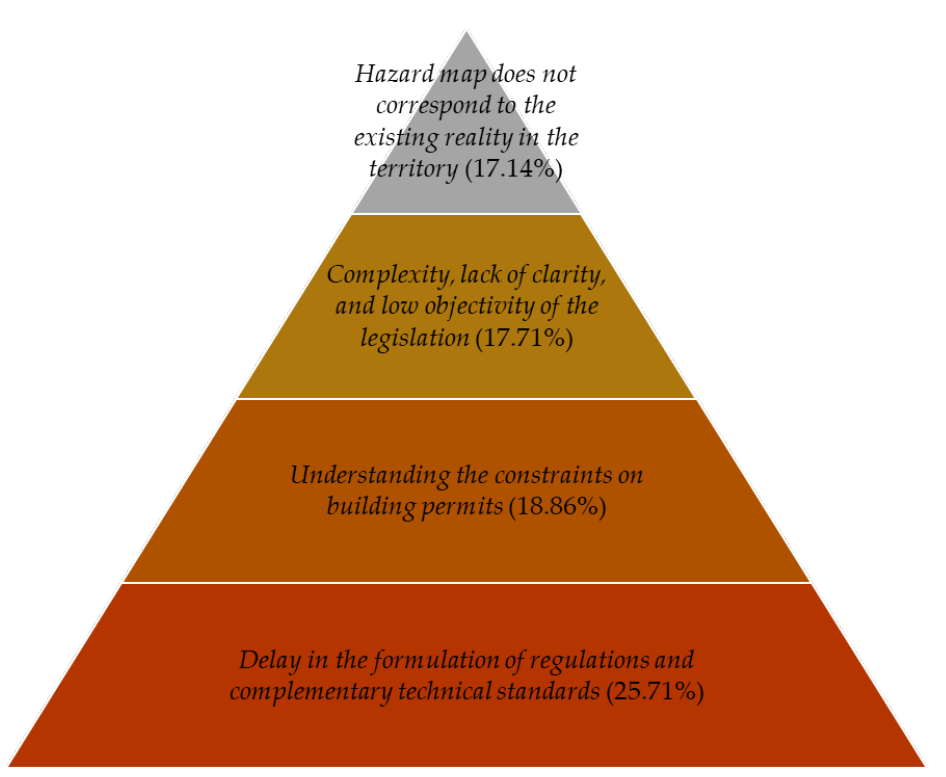
Figure 6. Main difficulties regarding the IMSRF implementation that should be